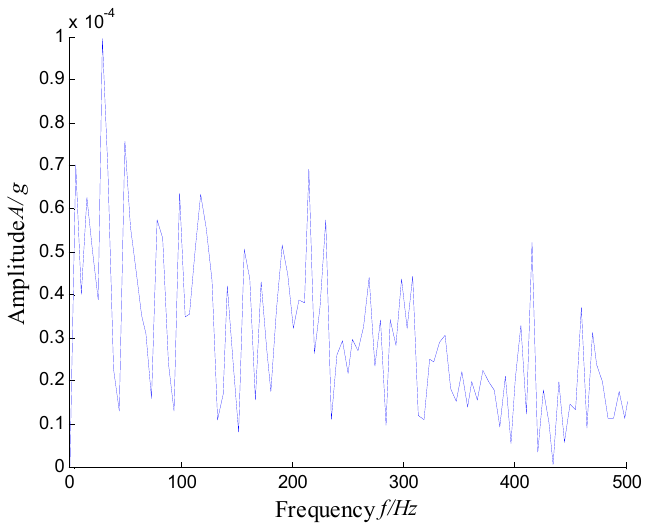
Figure 13. Envelope spectrum of the reconstructed signal obtained by the RSVD method.